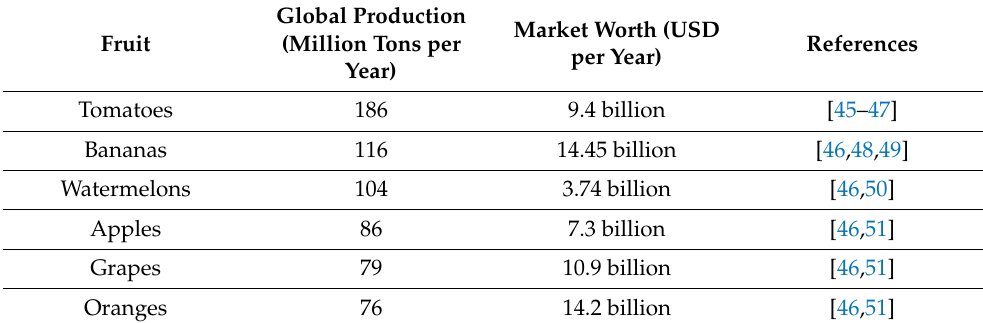
Table 2. The most-traded EFFs in the world.